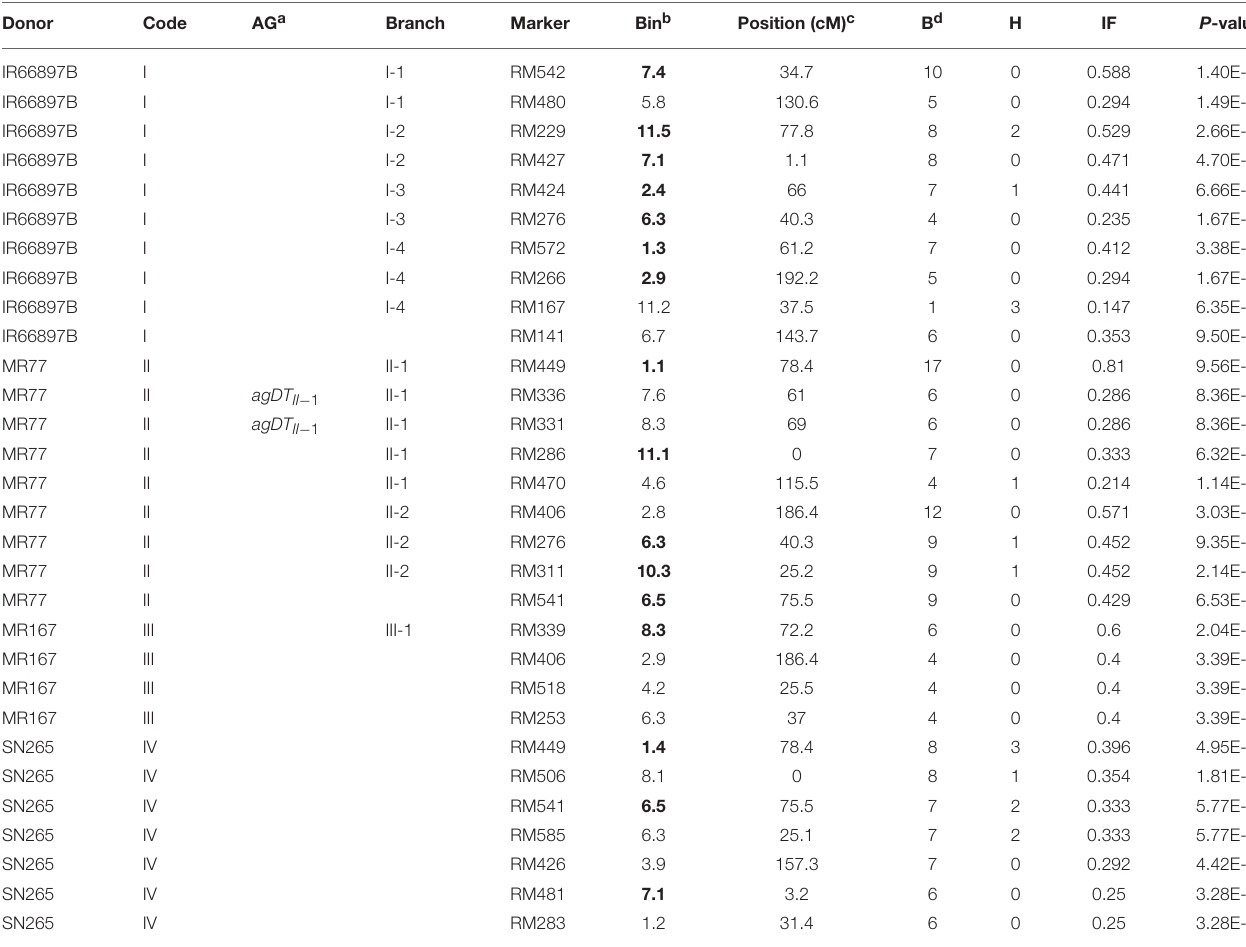
TABLE 6 | Genomic information for 29 functional genetic units (FGUs) (28 single loci and 1 association groups or AGs) for drought tolerance (DT) detected by χ 2 tests (single loci) and multi-locus linkage disequilibrium analyses in 72 drought-tolerant introgression lines (ILs) selected from four